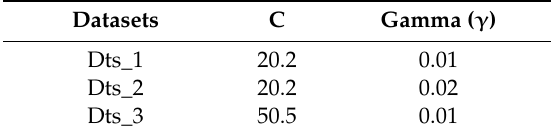
Table 14. Optimized C and Gamma parameters for the RBF-kernel.